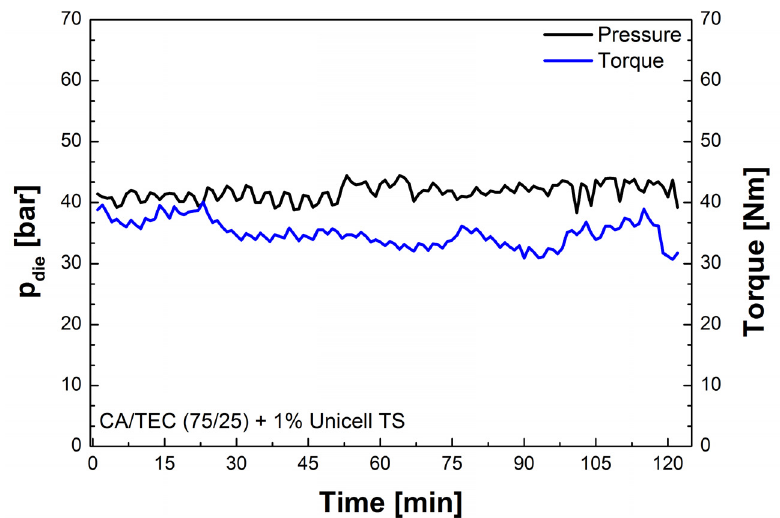
Figure 4. Torque and die pressure p and 1% Unicell